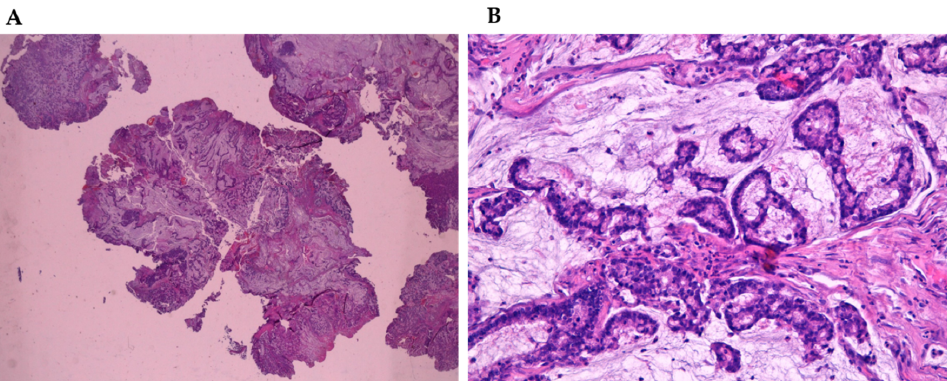
Figure 1. ( A ) Mucinous sinonsal adenocarcinoma (4×) stained with hematoxylin-eosin. ( B ) Mucinous sinonsal adenocarcinoma (40×) stained with hematoxylin-eosin.